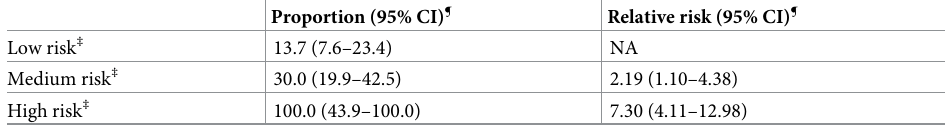
Table 4. Proportions and relative risks of persistent disability at 3 months �